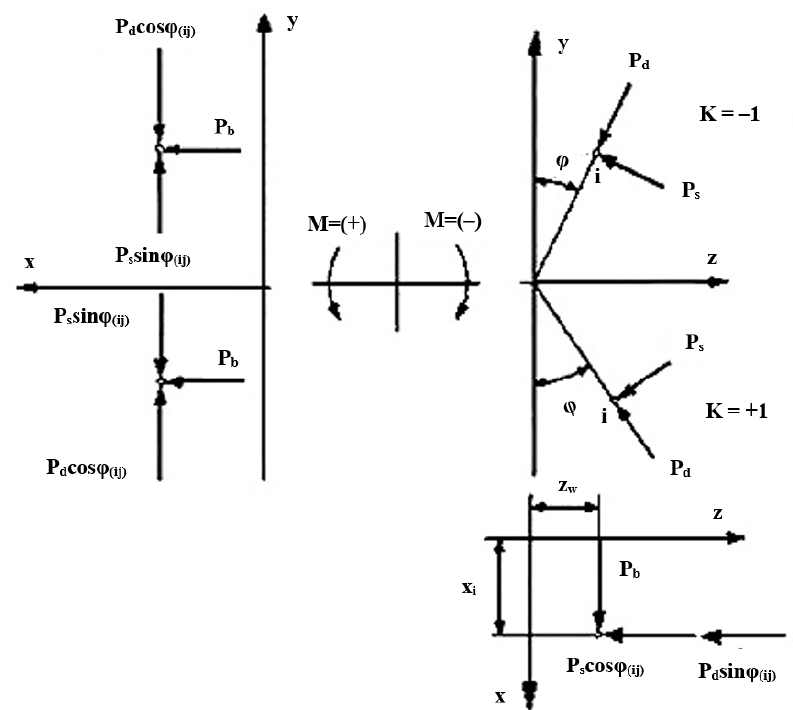
Figure 3. Diagram of the distribution of the components of cutting resistance forces on the i th pick [29].